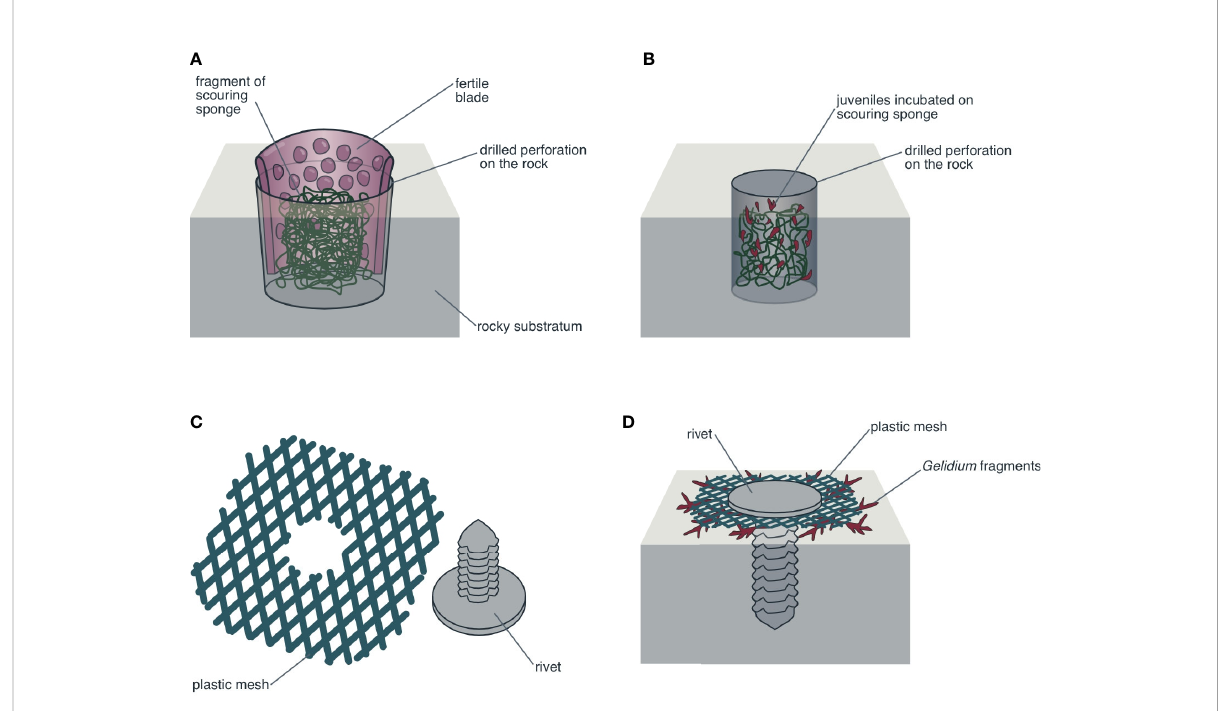
FIGURE 3 Mechanisms to produce new individuals on the rocks. (A) Fragment of reproductive blade of Mazzaella laminarioides trapped in position with a small fragment of abrasive sponge inside a perforation previously drilled in the substrate (intertidal rocky area), favoring the release of groups of spores in the area surrounding the perforation. (B) Fragment of abrasive sponge that has been previously inoculated with spores of M. laminarioides and incubated in the laboratory and after 4 – 6 weeks transplanted into holes previously drilled in the rocks. (C, D) Rivet and plastic mesh “ washer ” used to secure vegetative fragments of Gelidium lingulatum pressed against the substratum until secondary attachment structures are formed and the fragments regrow, generating new patches of this